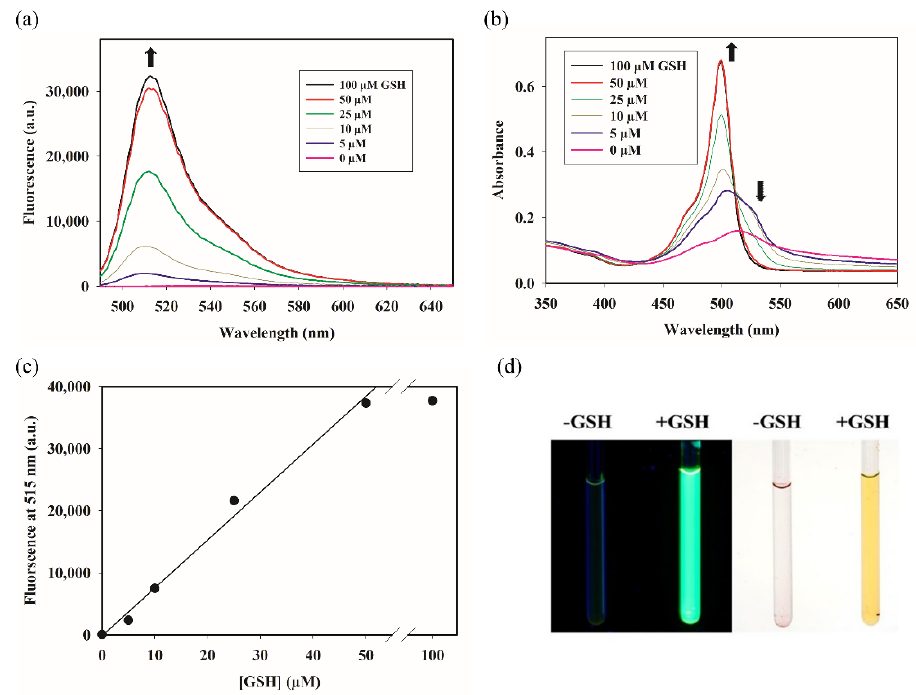
Figure 5. Fluorescent turn-on sensing of GSH by p-MB. ( a ) Fluorescence spectra of p-MB (50 µM) with varying concentrations of GSH in PBS containing 5% DMSO ( v / v ). ( b ) Absorption spectra of the solutions in ( a ), retaining the same color coding. Arrows denote the direction of change at the specified wavelengths as GSH concentration increases. ( c ) Plot of fluorescence intensity at 515 nm as a function of GSH concentration. The trendline only accounts for the concentrations up to 50 µM. The extra point at 100 µM is included to illustrate the signal saturation at an excess GSH concentration. ( d ) Image of samples containing p-MB (50 µM) in the presence or absence of GSH (500 µM) in PBS containing 5% DMSO. Left image was imaged under long wavelength UV light; right image was imaged under white light.